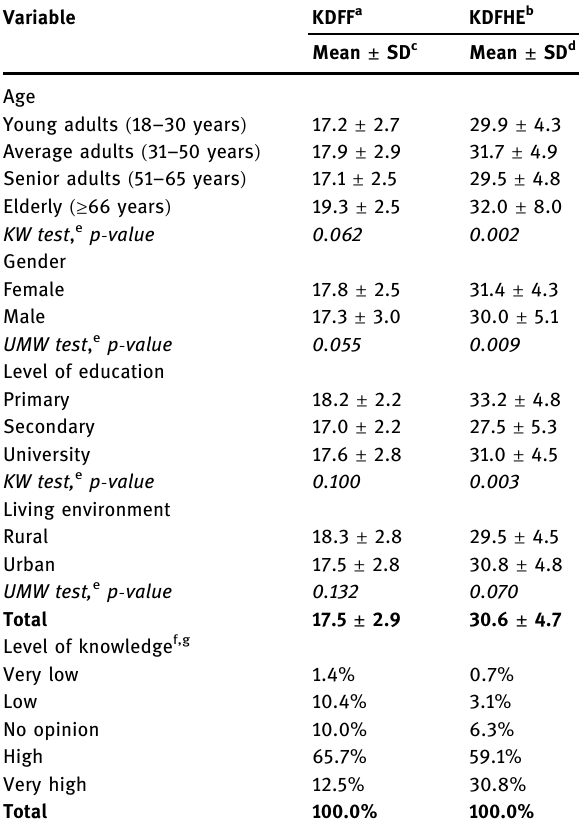
Table 3: Measurement of the General Level of Knowledge